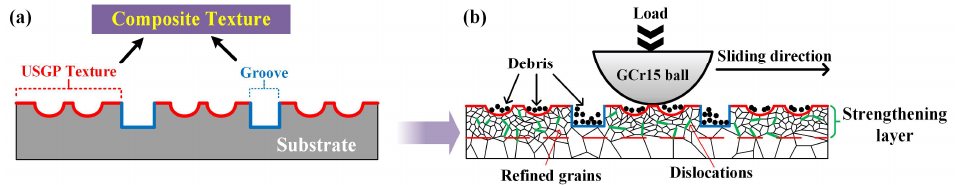
Figure 12. The sliding wear mechanism of the ULT sample: microstructure schematic diagram ( a ) and friction and wear mechanism model ( b ).